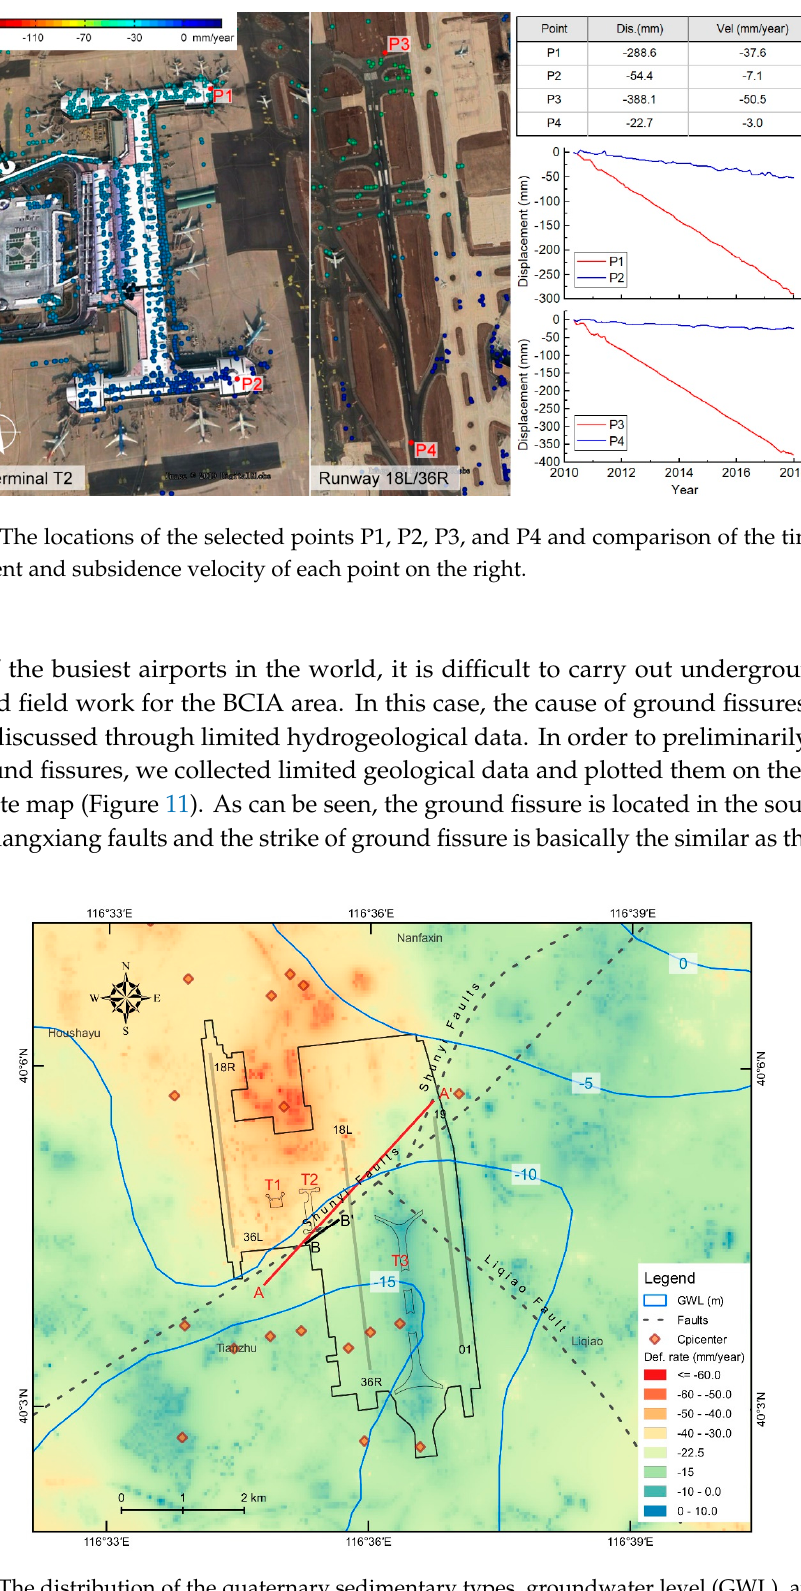
faults, with interpolated deformation rate (mm/year) in the study area. The black outlines show airport features, including terminals and airport boundaries. A—A’ indicates the location of the ground fissures identified by InSAR measurements, while the B—B’ indicates the same from Ma and